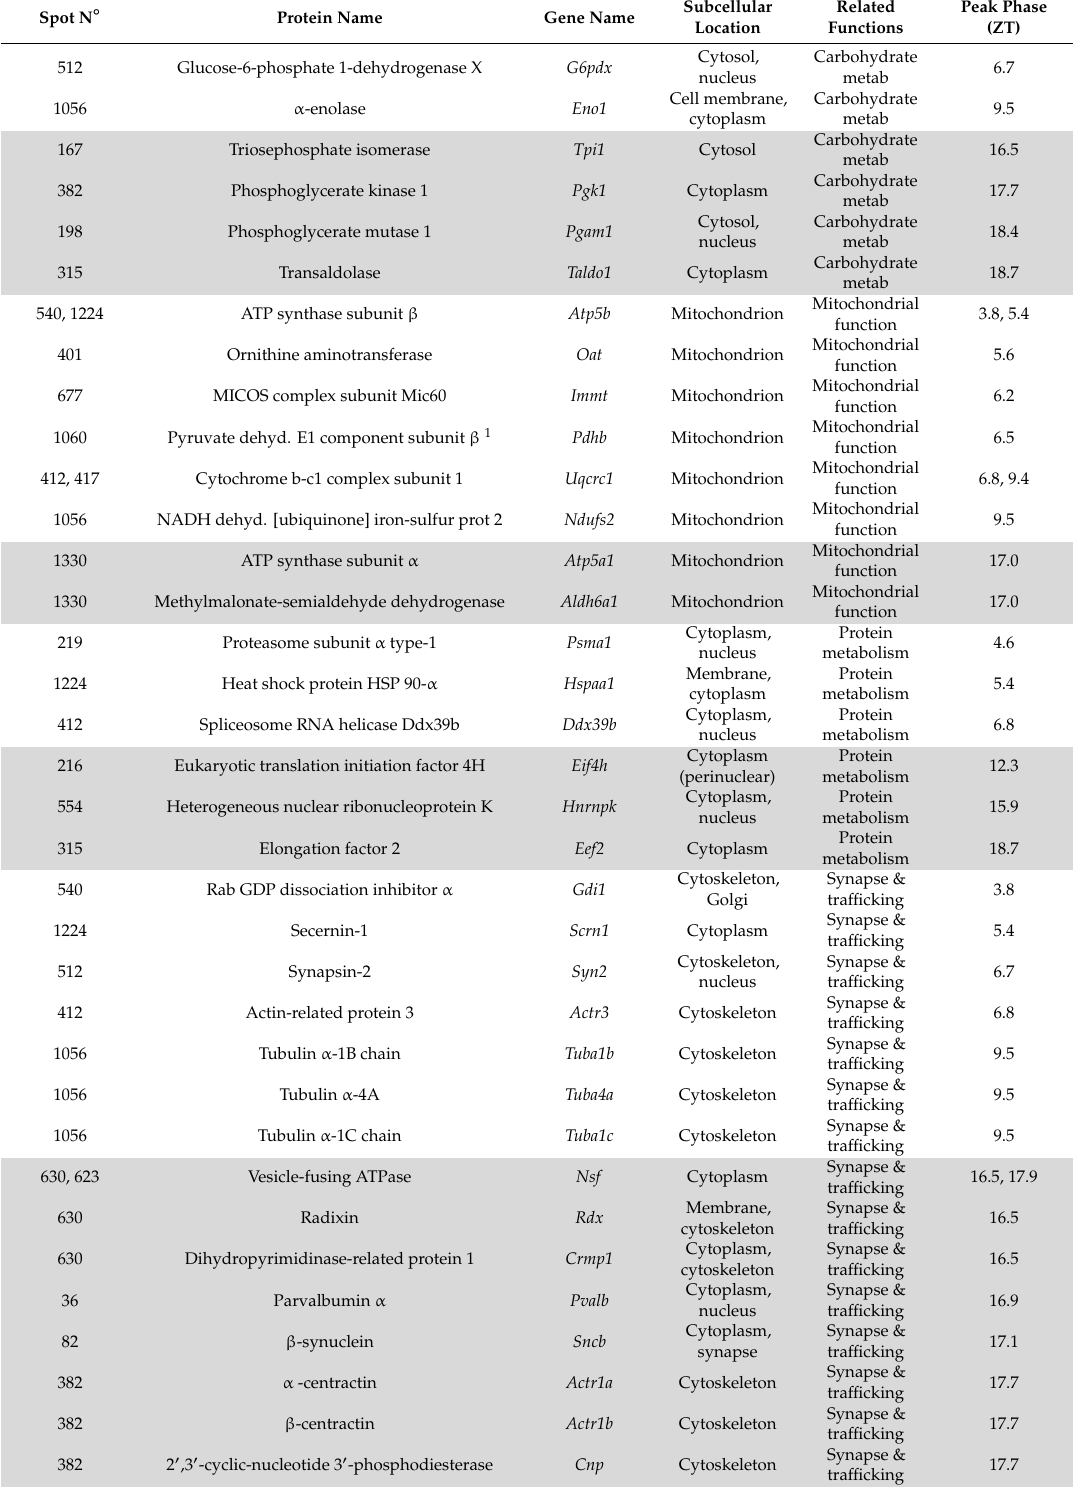
Table 1. Daily variations of abundant proteins in the mouse